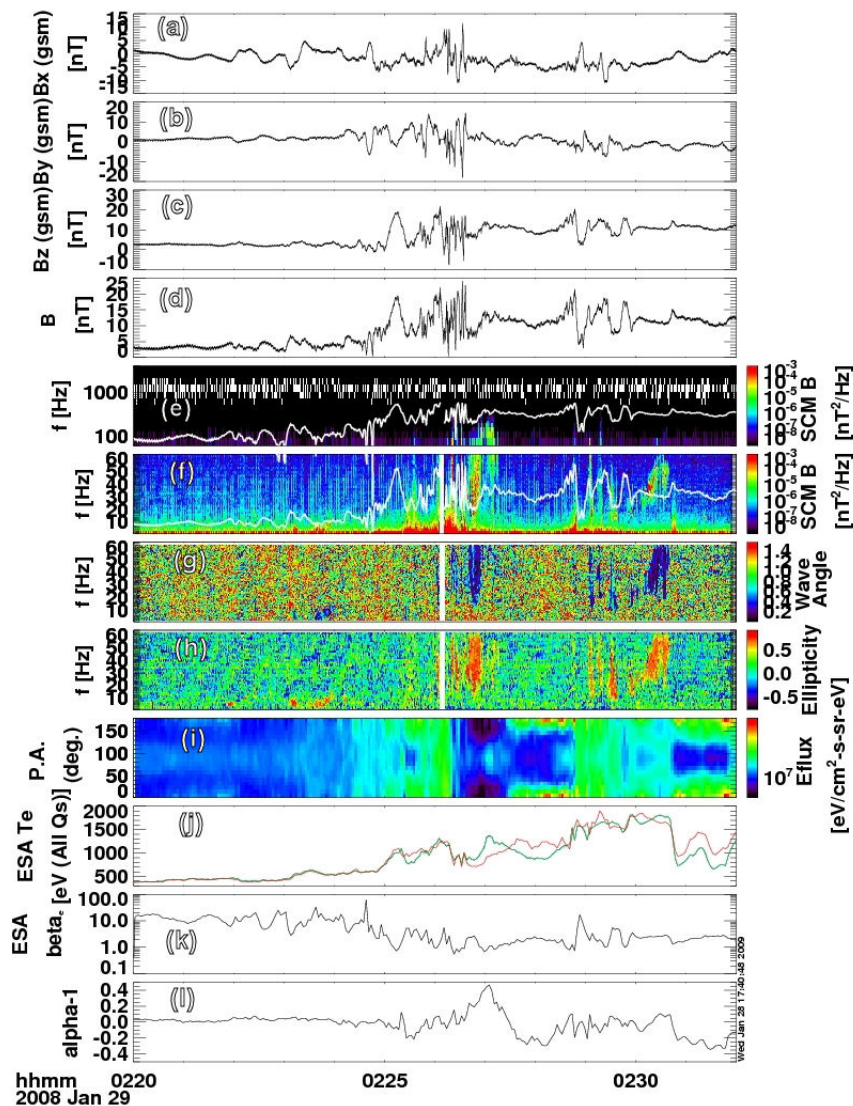
Fig. 4. Panels (a, b, c, d) : three components and modulus of the magnetic field (128S/s) in GSM coordinates, (e) B power spectral densities from onboard FFT and (f) from SCM waveform capture (one spectrum every 1s), White curve on panel (e) (resp. on panel f) correspond to | (cid:127) e | /( 2 π) (resp. 0 . 1 | (cid:127) e | /( 2 π) ). Note that the frequency scale is logarithmic on panel (e) and linear on panel (f). Panel (g) displays the angle between the wave vector and the background magnetic field (1s averaging), (h) ellipticity, (i) electron pitch-angle anisotropy spectrogram (ESA), (j) perpendicular (black and green lines) and parallel (red line) electron temperatures (ESA), (k) electron parallel β , and (l) α − 1 anisotropy